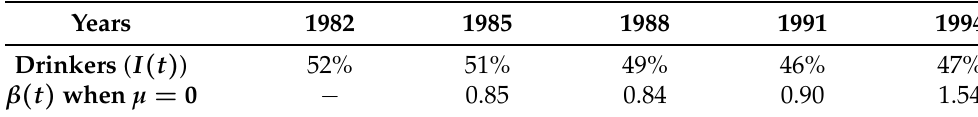
Table A4. Alcohol drinking data and estimates of β ( t ) .